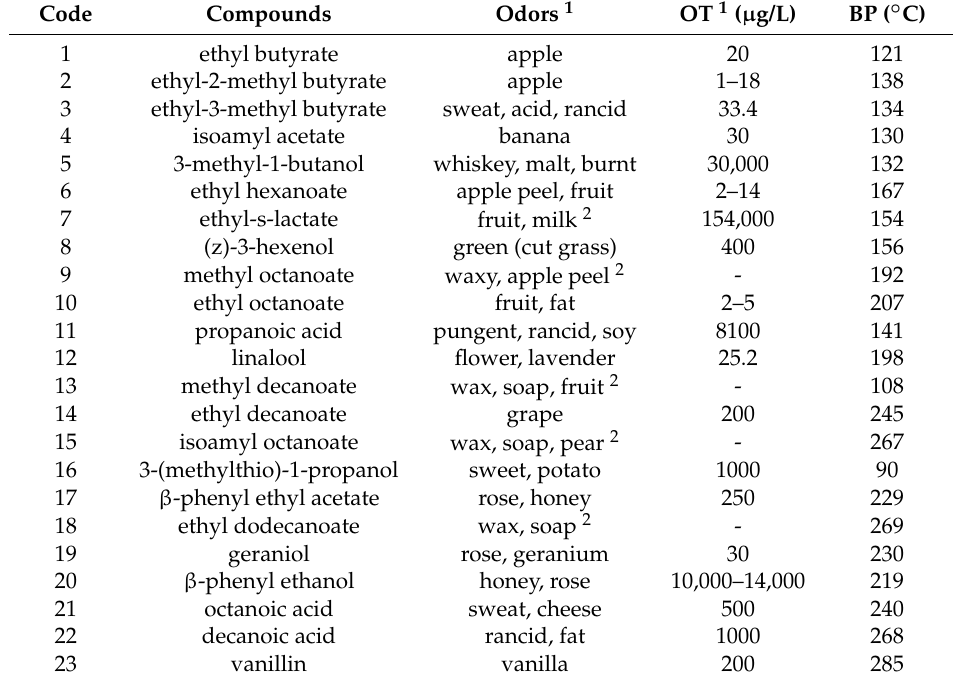
Table 1. The compound identification for Box-Behnken design, odors and olfactory thresholds, and boiling